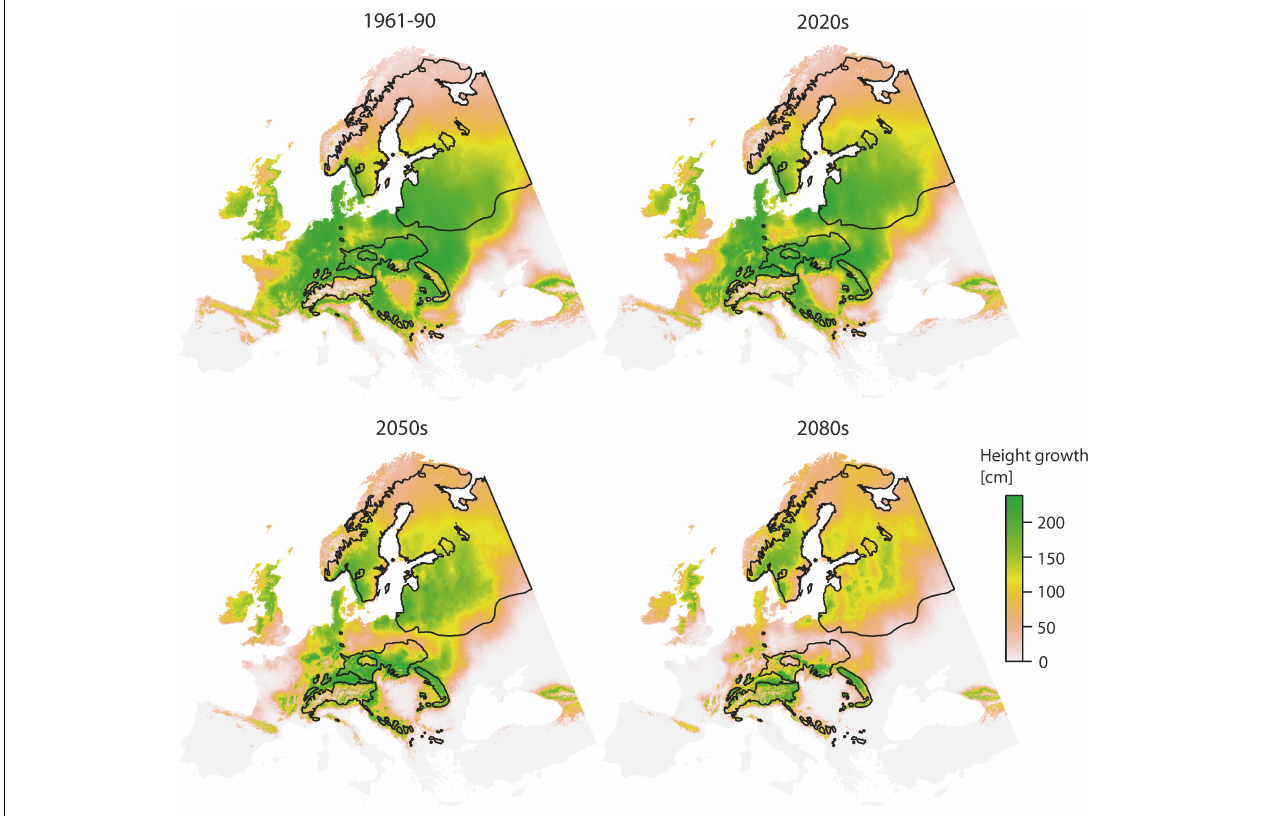
FIGURE 3 | Spatial prediction of the TraitSDM for height age 11 using “local” provenance for the 1961–1990 reference scenario and three predicted scenarios for the 2020s, 2050s, and 2080s. Black lines indicate the natural distribution. TABLE 5 | Full extent of the area potentially inhabitable for Norway spruce according to the TraitSDM and the area within expected to show superior juvenile height growth potential ≥ 200 cm. Full extent of inhabitable area (HT > 0 cm) Area with superior height (HT > 200